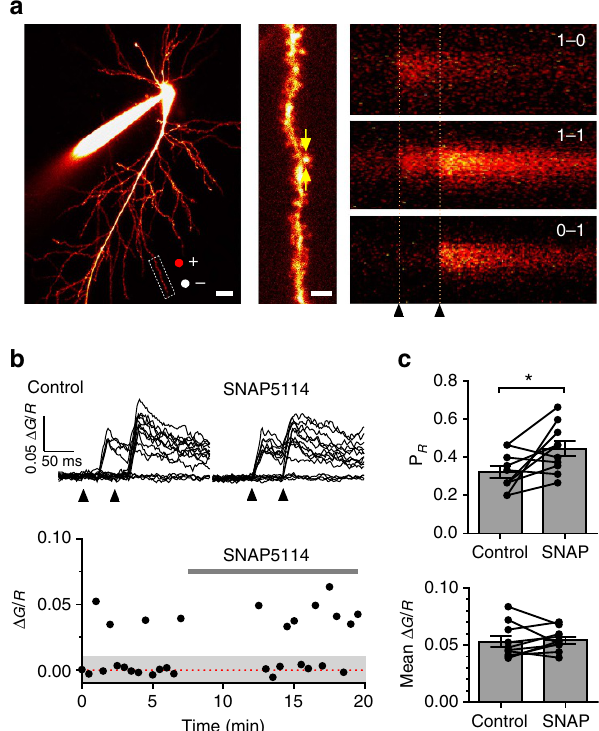
Figure 2 | GAT-3 inhibition increases release probability at individual CA3-CA1 synapses. ( a ) Left: Example of recorded CA1 pyramidal neuron (Alexa 594 channel; scale bar, 20 m m). Stimulating pipette locations marked by red and white dots (positive and negative poles). Dashed rectangle indicates a dendritic fragment of interest. Magnified image of the dendrite (Centre; scale bar, 4 m m) shows the position of a line-scan (arrows). Right: Line-scans of the fragment shown in Fluo-2 MA channel. Three typical cases of stochastic responses to paired stimuli (dotted lines) are shown (0 and 1 indicate signal failures and successes, respectively). ( b ) Top: Ca 2 þ fluorescence time course traces (recorded as in a) before and after SNAP application (arrow heads: stimulus onsets). Bottom: Amplitudes of first Ca 2 þ responses in the same experiment (grey shade: the range of failure, twice the baseline noise s.d.). ( c ) Change in release probability ( upper ) and Ca 2 þ D G / R average amplitude of successful responses ( lower ) in response to SNAP5114 ( n ¼ 10 cells from 10 animals).